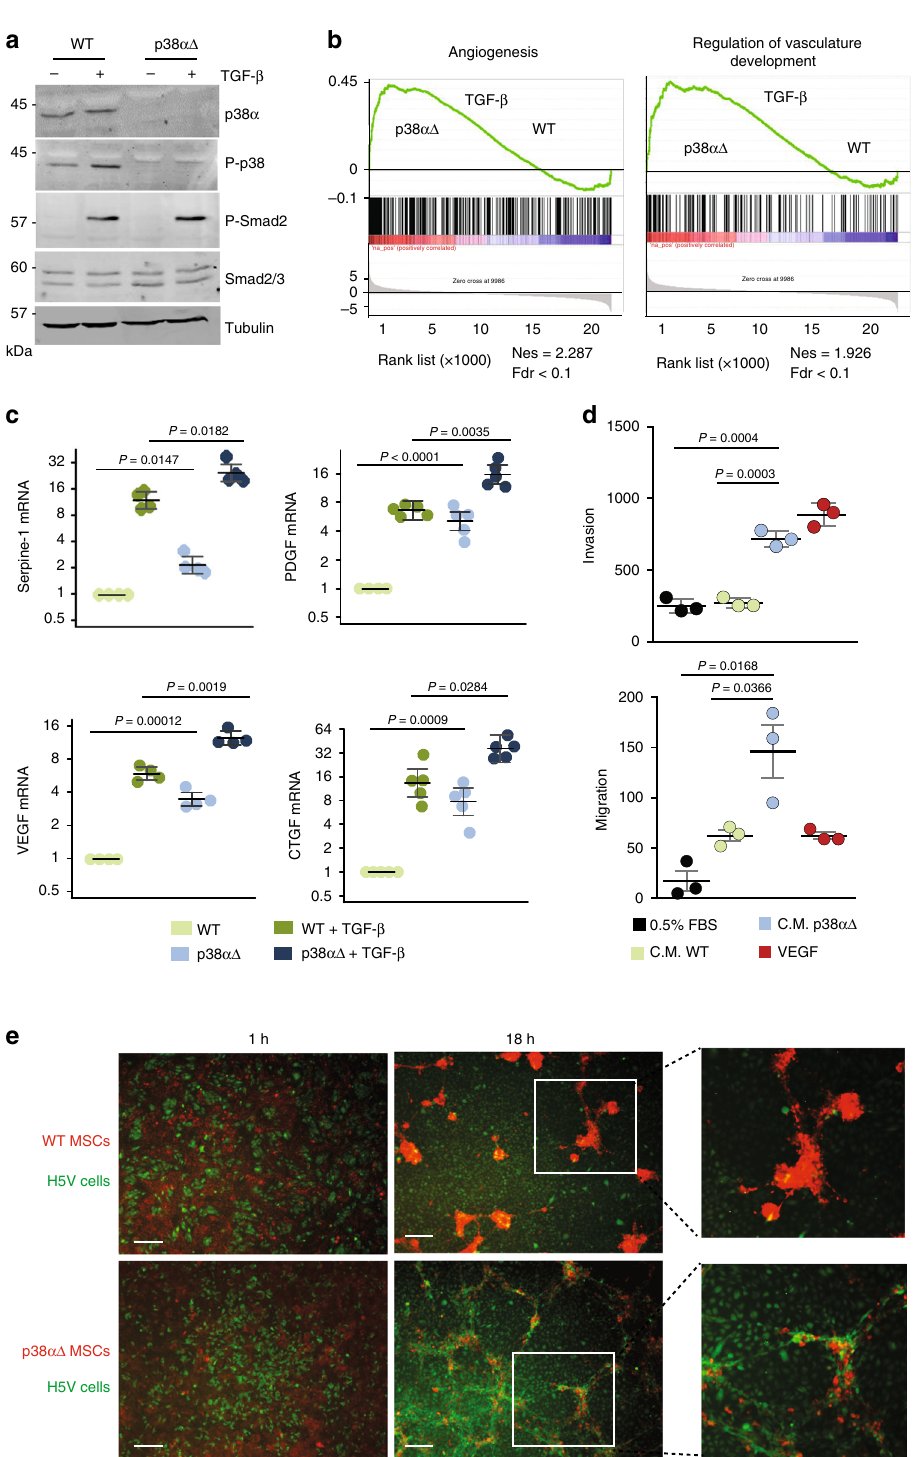
Fig. 2 p38 α negatively regulates TGF- β signaling and the expression of angiogenesis genes in MSCs. a MSCs were obtained from Mapk14 lox/lox ;UBC-Cre- ERT2 mice, immortalized and then incubated with 4-OHT for 2 days to obtain p38 αΔ MSCs. WT MSCs were treated with vehicle. Cells were starved (0.5% FBS) and treated with TGF- β for 20h, and total protein lysates were analyzed by immunoblotting. b Gene set enrichment analyses (GSEA) of Angiogenesis (GO: 001525) and Regulation of vasculature development (GO: 1901342) comparing WT and p38 αΔ MSCs treated or not with TGF- β . Nes normalized enrichment score, Fdr false discovery rate. c Relative levels of the indicated mRNAs in WT and p38 αΔ MSCs treated with TGF- β . Values are graphically represented in log2 scale and show the fold change versus WT. Data represent mean ±SEM ( n = 4) and CTGF ( n = 5). d H5V endothelial cells were used for migration and invasion assays on Boyden chambers in the presence of 0.5% FBS, VEGF (10ng/ml) or conditioned medium (C.M.) prepared from WT and p38 αΔ MSCs after 48h of culture. Quanti fi cations were performed after 6 h for the migration assays or 16h for the invasion assays by counting the number of crystal violet-stained cells in different fi elds. Data are means± SEM ( n = 3). e Co-cultures of H5V endothelial cells and MSCs pre-stained with cell tracker green and red, respectively, in DMEM 10% FBS for the indicated times. Bars, 100 μ m. The right panels show higher magni fi cations of the indicated